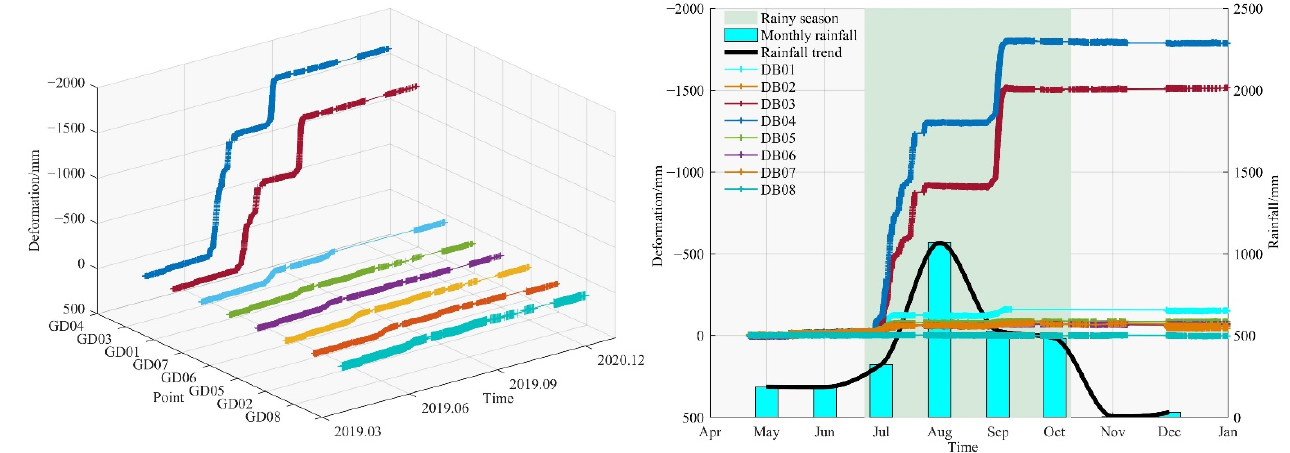
Figure 7. Monitoring data.